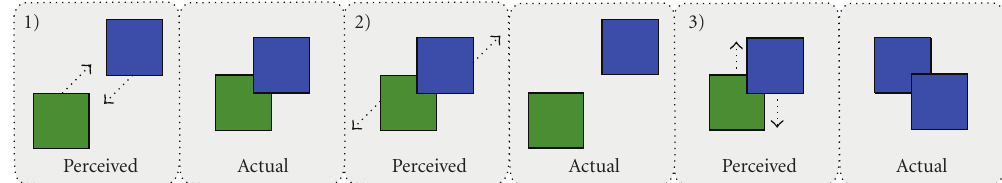
Figure 9: Player collisions with simultaneous